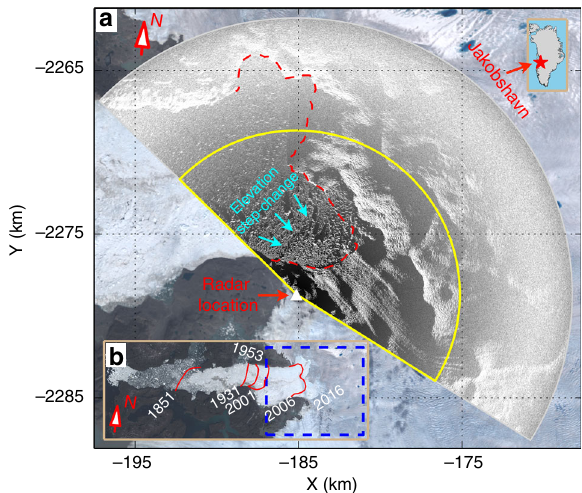
Fig. 1 TRI scan area. a TRI amplitude image overlain on a Landsat-8 image (both acquired on 13 June 2016). Black areas are in radar line-of-sight (LOS) shadow. Yellow line outlines the area within 10 km of the radar, shown in Fig. 2a. Dashed red line indicates glacier front location. Cyan arrows mark the elevation step-change in the mélange. Upper right inset shows location of Jakobshavn Isbræ in Greenland. b Dashed blue box outlines the area presented in a . Red lines show calving front positions in different years, courtesy of NASA Earth Observatory. Both a and b are in polar stereographic projection (EPSG: